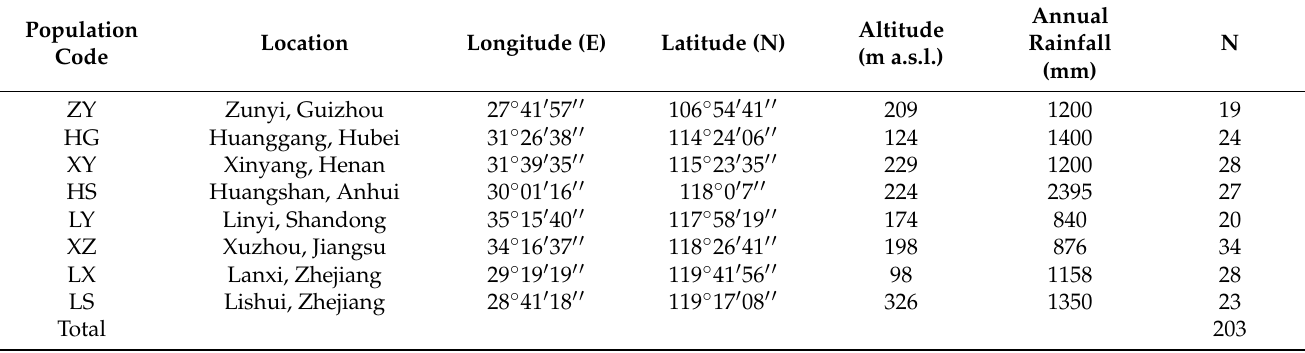
Table 1. The origins of the eight T. sebifera (Linnaeus)